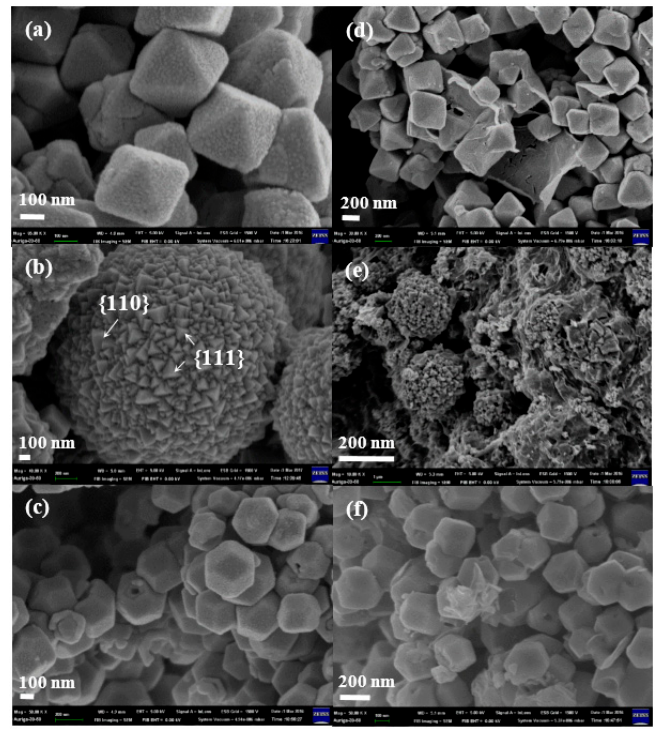
Figure 2. Scanning electron microscope (SEM) images of ( a ) o-Cu 2 O; ( b ) h-Cu 2 O; ( c ) r-Cu 2 O; ( d ) o-Cu 2 O-G; ( e ) h-Cu 2 O-G and ( f ) r-Cu 2 O-G.